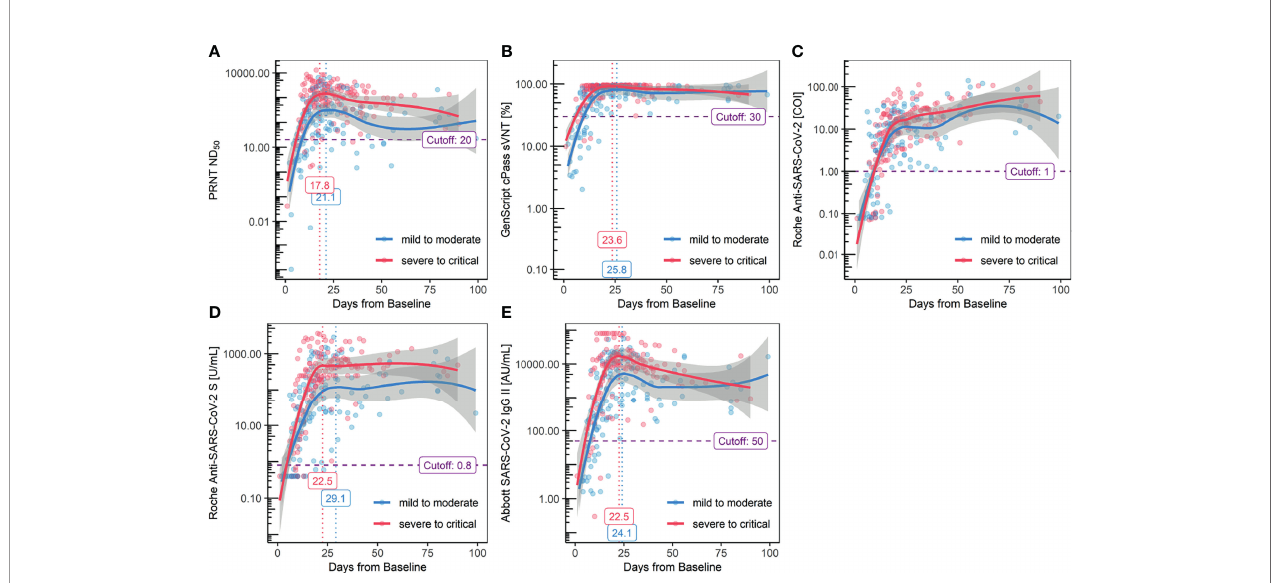
FIGURE 2 | Serial kinetics of antibody titers measured with each method: (A) PRNT ND50, (B.) GenScript cPass sVNT, (C) Roche Elecsys Anti-SARS-CoV-2, (D) Roche Elecsys Anti-SARS-CoV2 S, and (E) Abbott AdviseDx SARS-CoV2 IgG